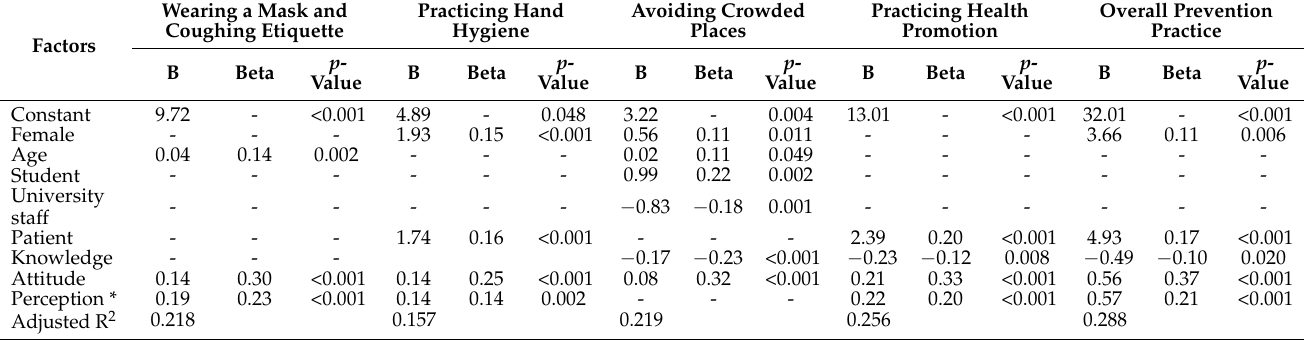
Table 4. Factors Predicting Practices in Prevention of COVID-19 among participants ( n = 480).